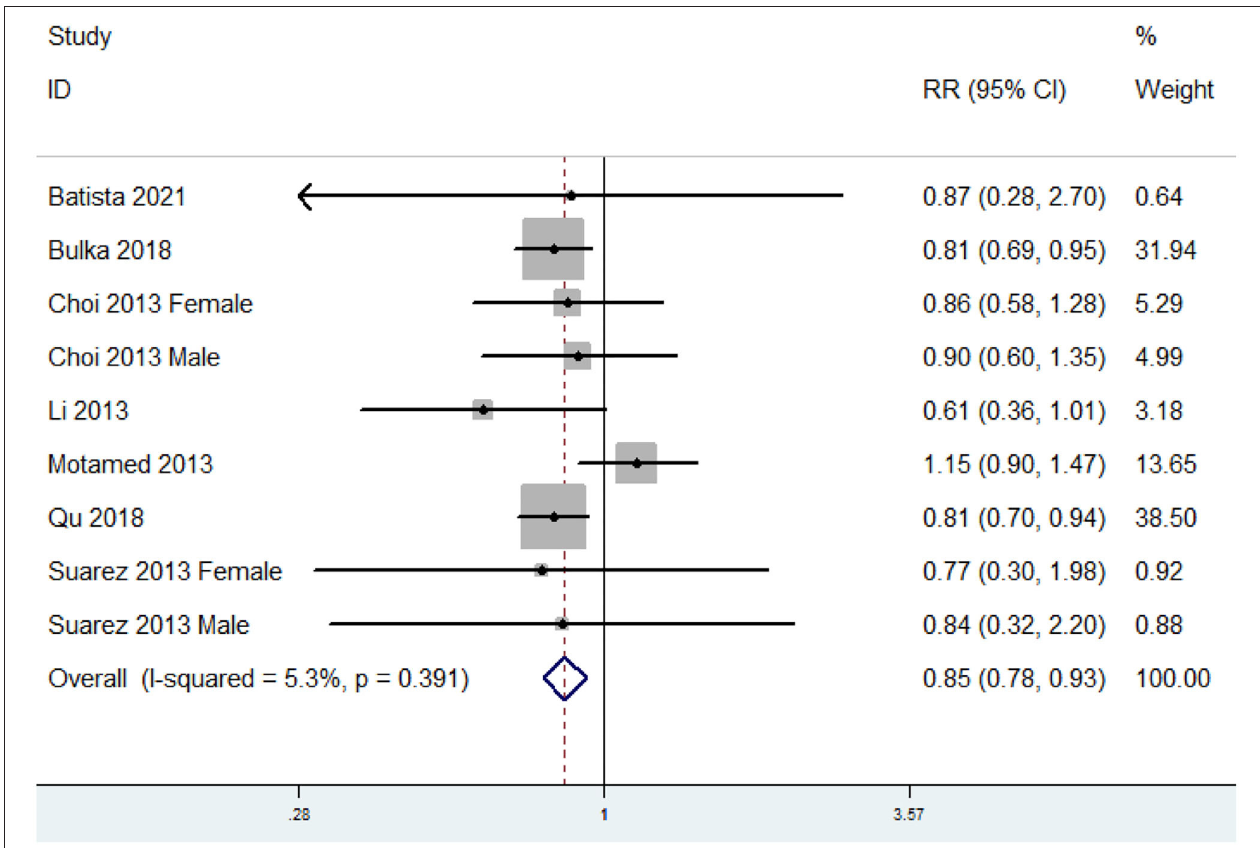
FIGURE 3 | Forest plot of meta-analysis: Overall multi-variable adjusted RR of MetS for the highest vs. lowest dietary copper level.